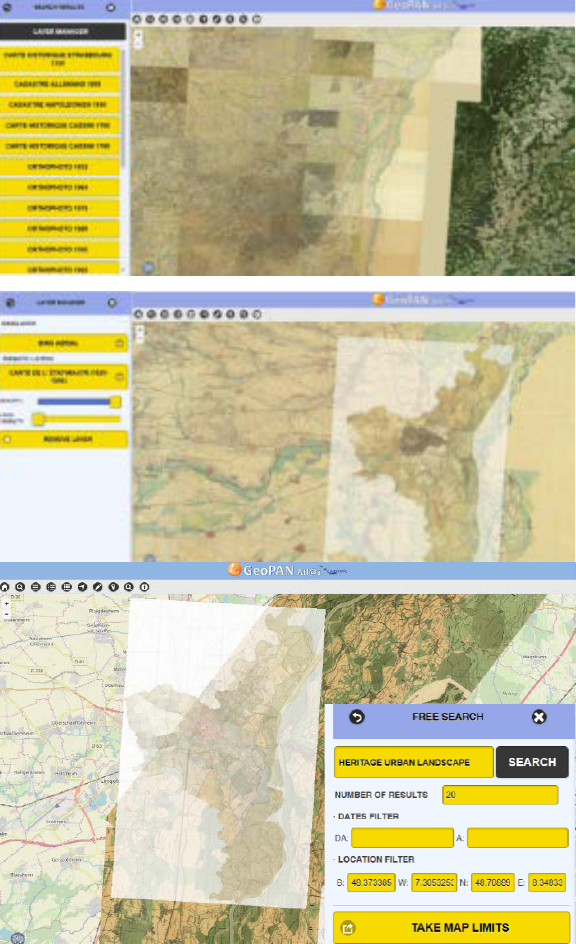
Figure 6. The GEOPAN APP access to the Strasbourg area by urban landscape query search. The different maps that can be accessed and compared together with the current maps and the historical ones published by the City of